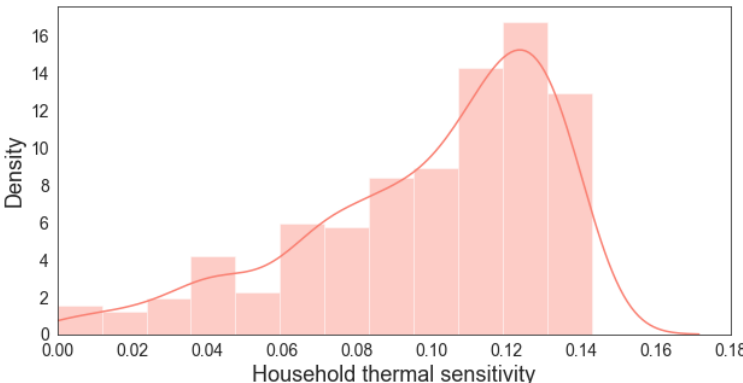
Figure 10. Density distribution of the household thermal sensitivity across the 482 investigated dwellings [10].